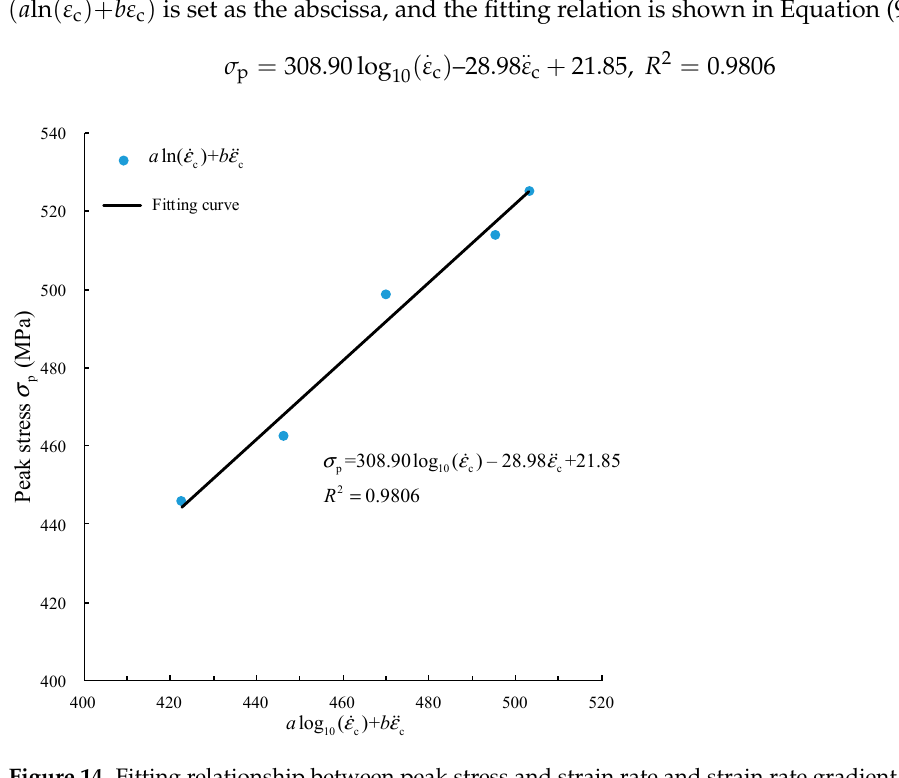
Figure 14. Fitting relationship between peak stress and strain rate and strain rate gradient.